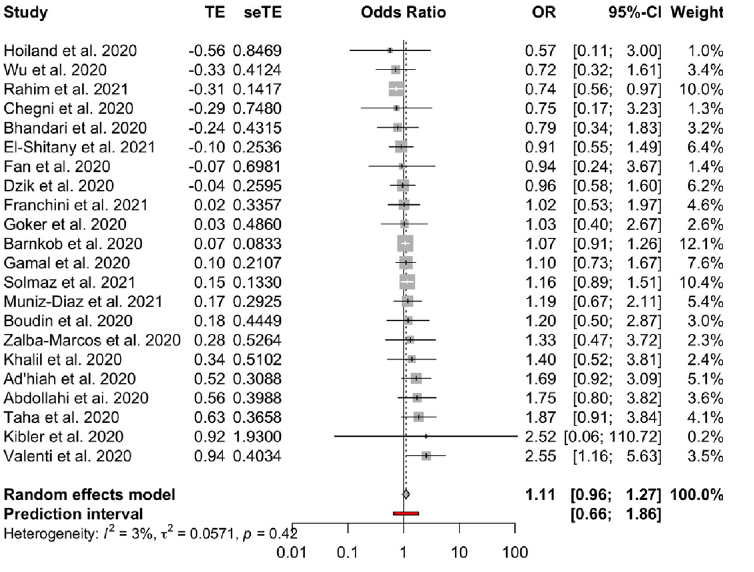
Fig 5. Forest plots for the ABO gene comparison of B vs. AB